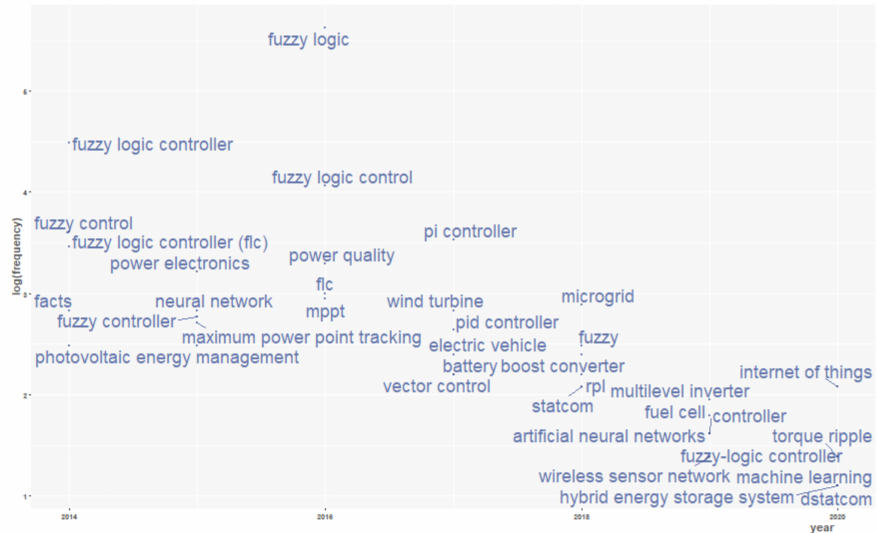
Figure 18. Trending topics according to